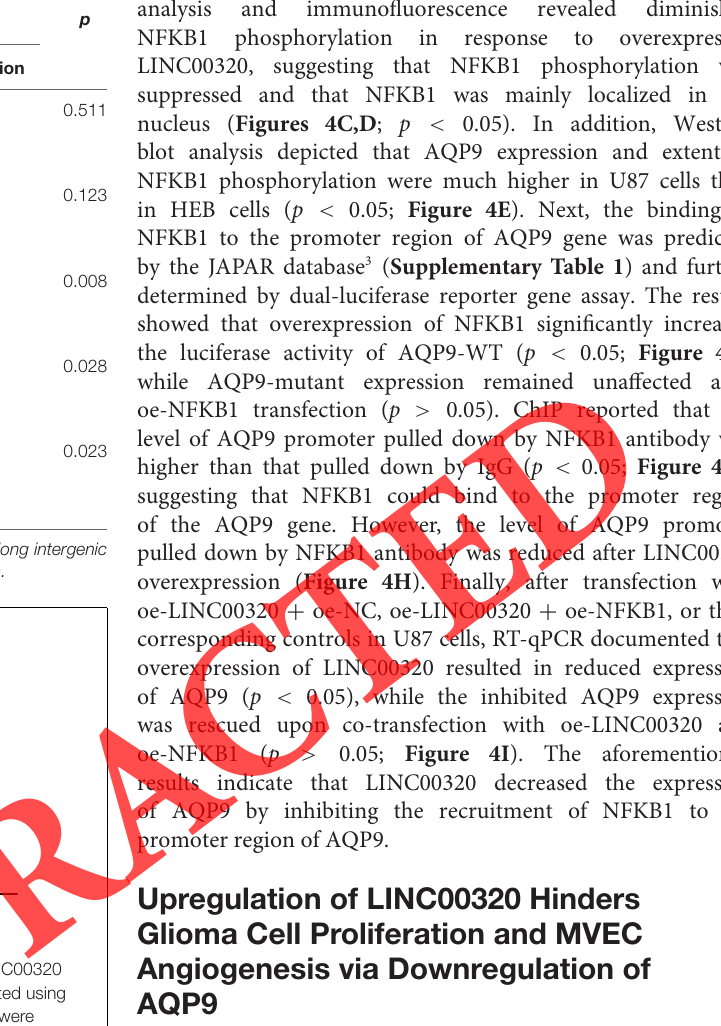
FIGURE 2 | LINC00320 was expressed poorly in glioma cells. LINC00320 expression in HEB, LN229, U87, U251, and T98G cell lines detected using RT-qPCR normalized to β -actin. * p < 0.05 vs. HEB cell line. Data were expressed as mean ± standard deviation, and comparisons among multiple groups were conducted by one-way ANOVA, followed by a Tukey multiple-comparisons posttest. The experiment was repeated three times